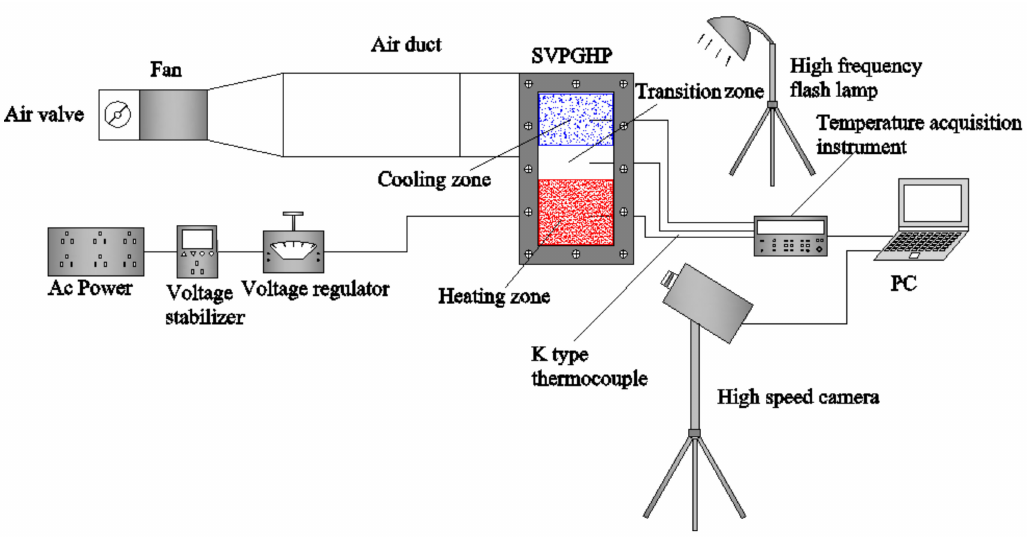
Figure 4. Test system of the